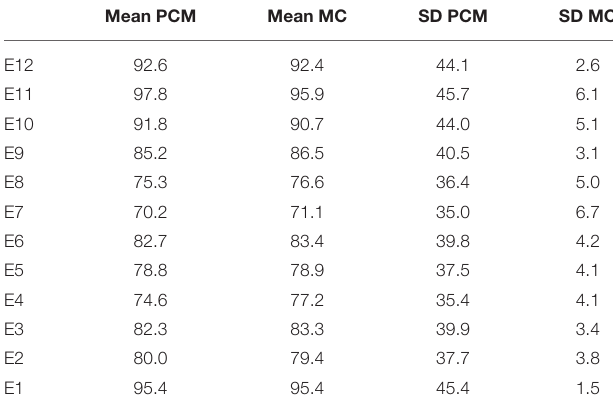
TABLE 2 | Cross-turn stimulation